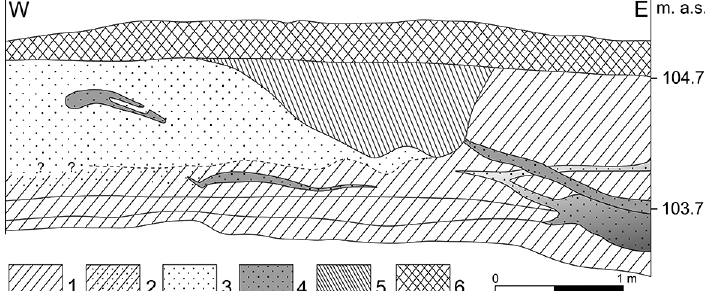
Fig. 7. Profile of archaeological section 47 according to Petri and Bakiewicz (2002, simplified), with a visible outline of a river bed filled with dark-brown sediments. 1 – clay with humic admixtures, 2 – sandy clay, 3 – sand with artefacts, 4 – sand with humus, 5 – dark brown sand, 6 – humic sand (described by archaeologist as an arable layer).